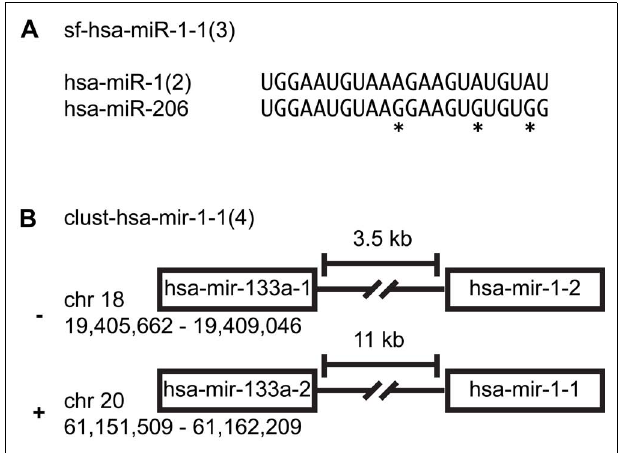
FIGURE 1 | miRNA family clusters. (A) An example of a miRNA sequence family cluster. An asterisk indicates nucleotides that differentiate the two miRNAs. (B) An example of a precursor family cluster.While hsa-mir-1-1 and hsa-mir-1-2 are not on the same chromosome, their sequence composition makes them